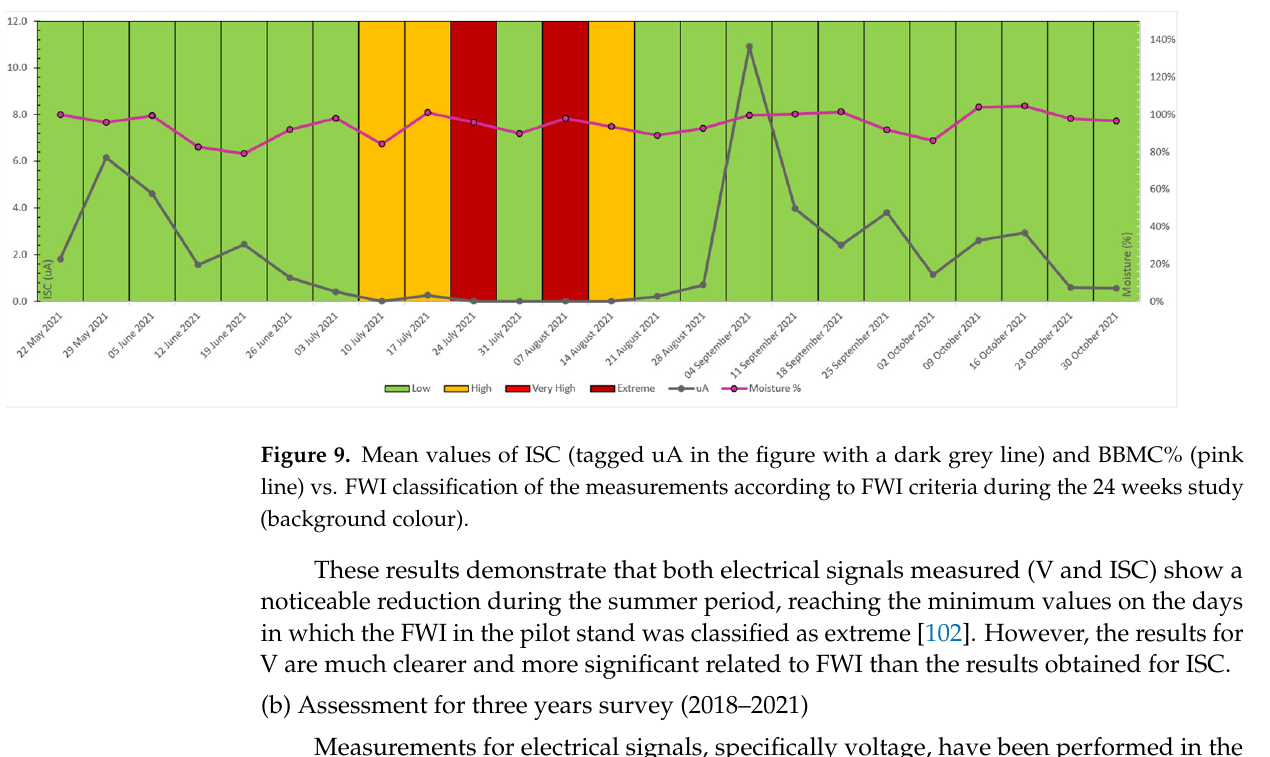
Figure 8. Mean values of V (blue line) and BBMC% (pink line) vs. FWI classification of the measure- ments according to FWI criteria during the 24 weeks study (background colour).